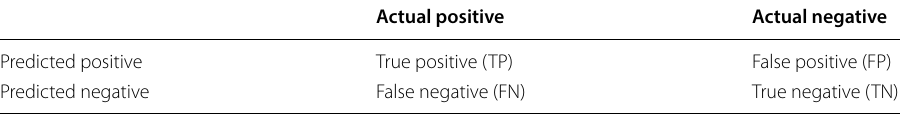
Table 9 Confusion matrix where the positive class are faults and the negative class are normal data points